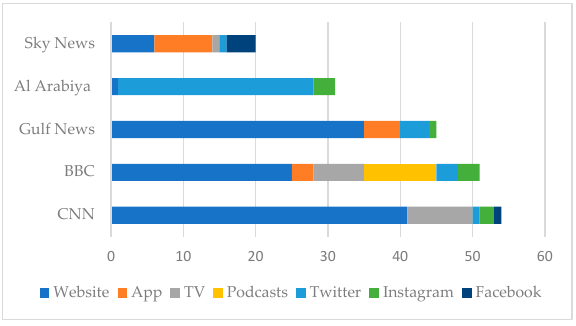
Figure 3. Top five traditional sources by platform. Information 2020 , 11 , 375